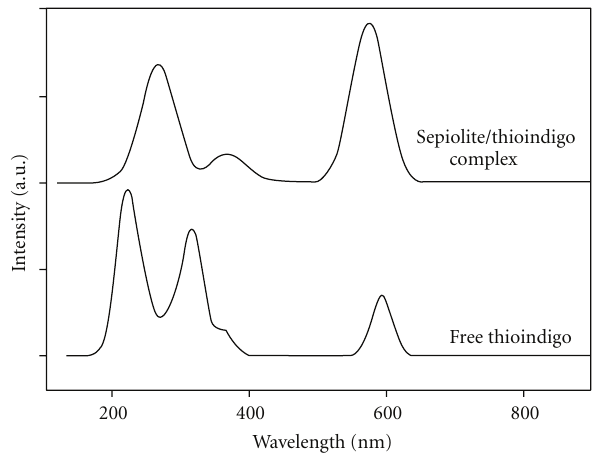
Figure 4: Computational color change in sepiolite-bonded thioin- digo. The UV-Vis spectra are displaced vertically for clarity.